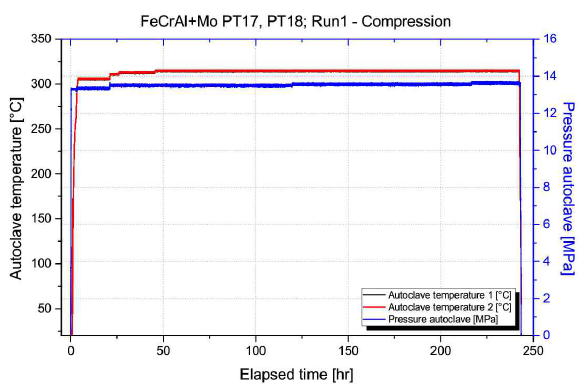
Figure 10. Visual inspection of FeCrAl+Mo pressure tubes after Run 1 - compression.